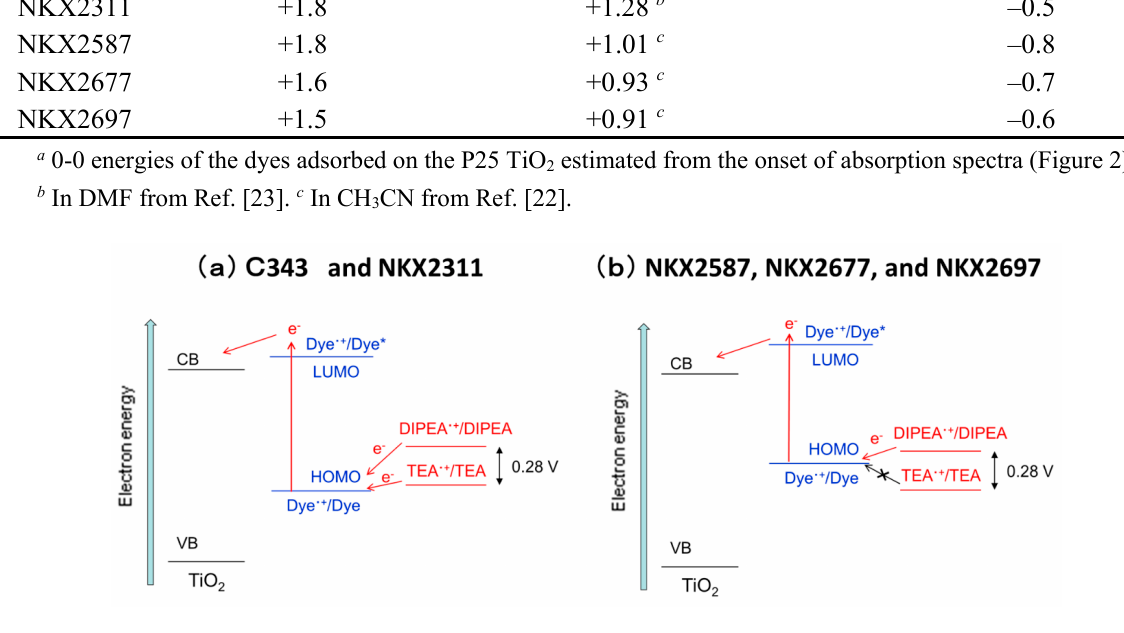
Figure 3. Energetics and electron transfer processes occurring on the dye-sensitized TiO 2